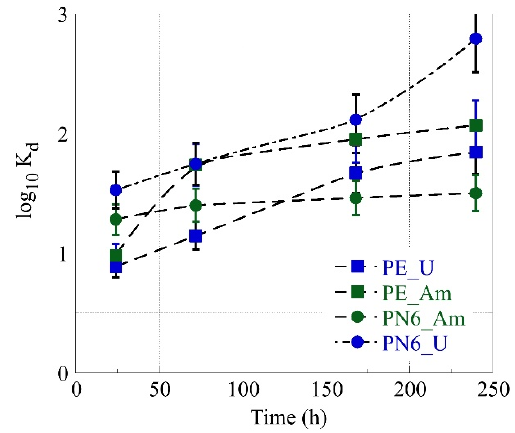
Figure 2. K d values for the Am(III) and U(VI) sorption by PE and PN6 microplastics from a Am-241 and U-232 mixture solution, as a function of contact time at pH 4.